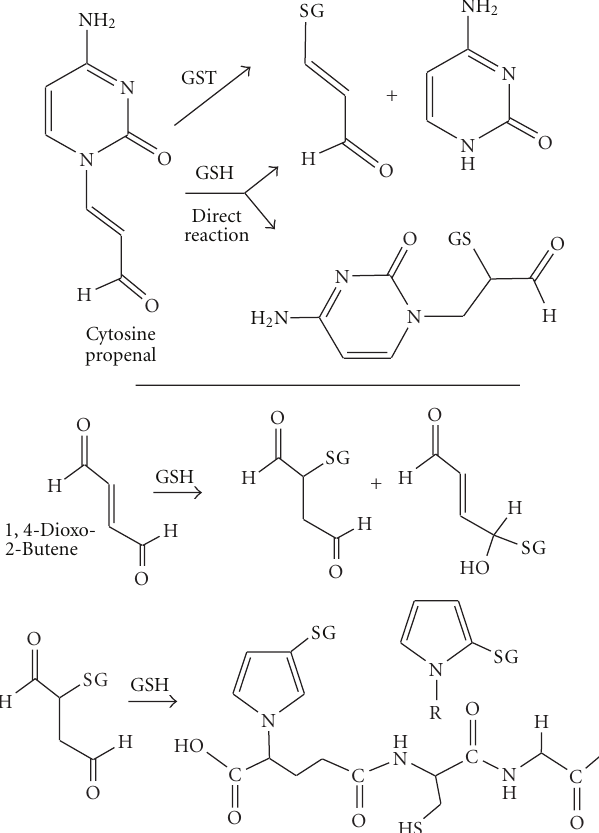
Figure 10: Formation of glutathione adducts of 2-deoxyribose oxidation